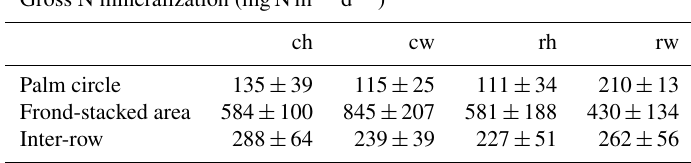
Table A2. Gross N mineralization rates (mean ± standard errors, n = 4 plots) in the top 5cm of soil for each treatment and management zone in a large-scale plantation in Jambi, Indonesia. Measurements were done on intact soil cores in February 2018 using the 15 N pool dilution technique, as described in detail by Allen et al. (2015). Treatments: ch is conventional fertilization–herbicide, cw is conventional fertilization–mechanical weeding, rh is reduced fertilization–herbicide, and rw is reduced fertilization–mechanical